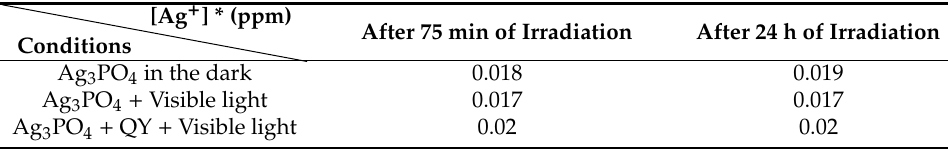
Figure 13. Reusability of Ag 3 PO 4 photocatalyst. XRD pattern after three cycles ( a ). Degradation yield after 40 min of irradiation under visible light for three runs ( b ). ([QY] 0 = 20 ppm, Ag 3 PO 4 dose = 0.5 g · L − 1 and pH~7). Table 4. Solubility of Ag 3 PO 4 in different conditions.